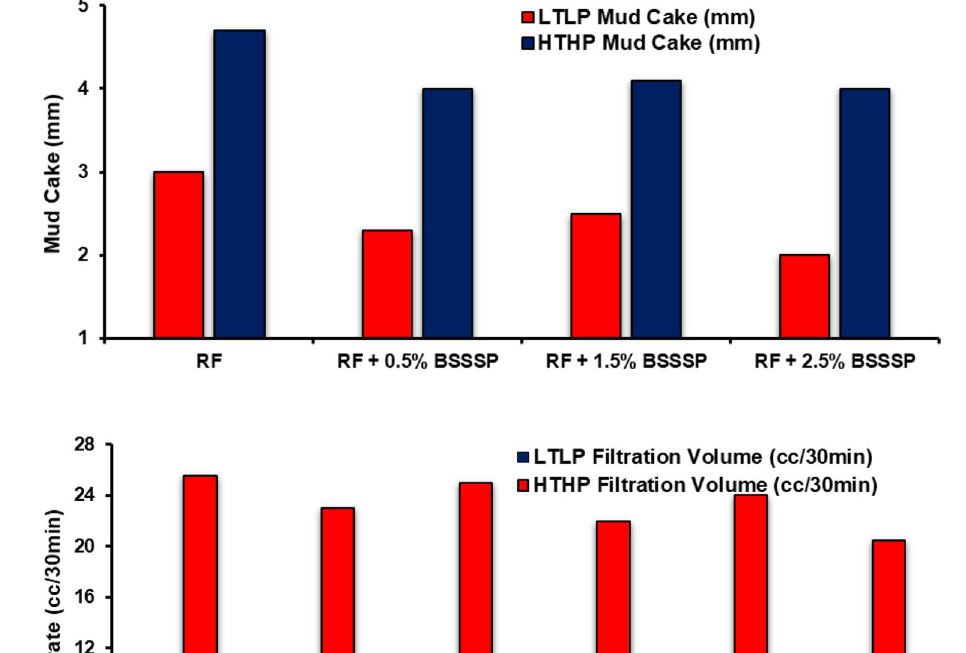
Fig. 11 Comparison between the effects of BSSSP on the filter cake under the fresh and aged